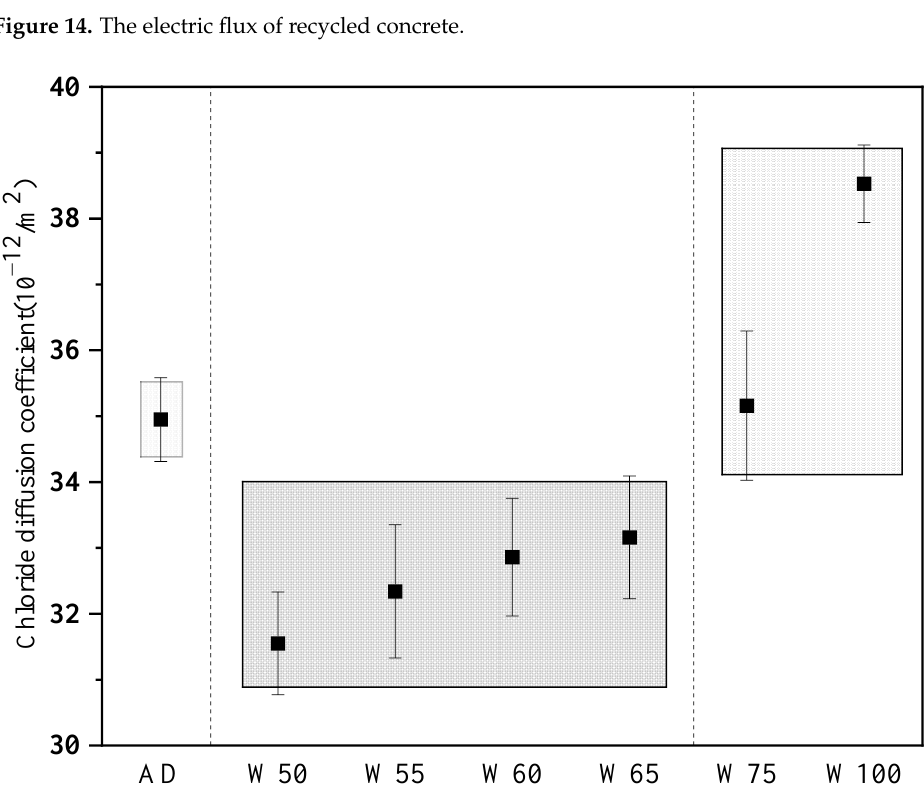
Figure 15. 28 d chloride diffusion coefficient of recycled